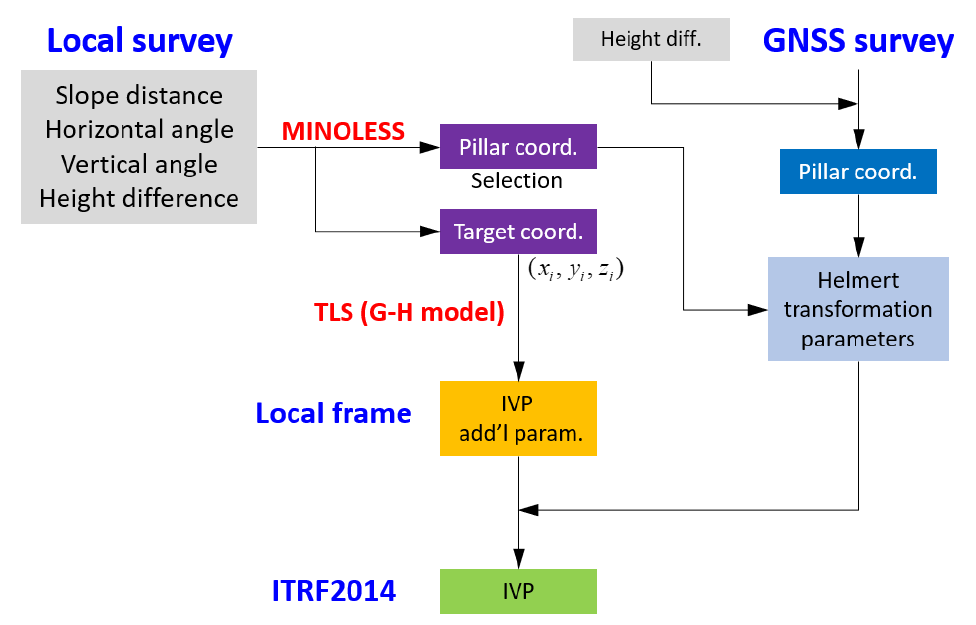
Figure 2. Flow chart to estimate the VLBI IVP [24]. The ground surveying and the GNSS campaign are conducted under two reference frames. The IVP estimated in local frame is transformed into the global frame via the conventional Helmert